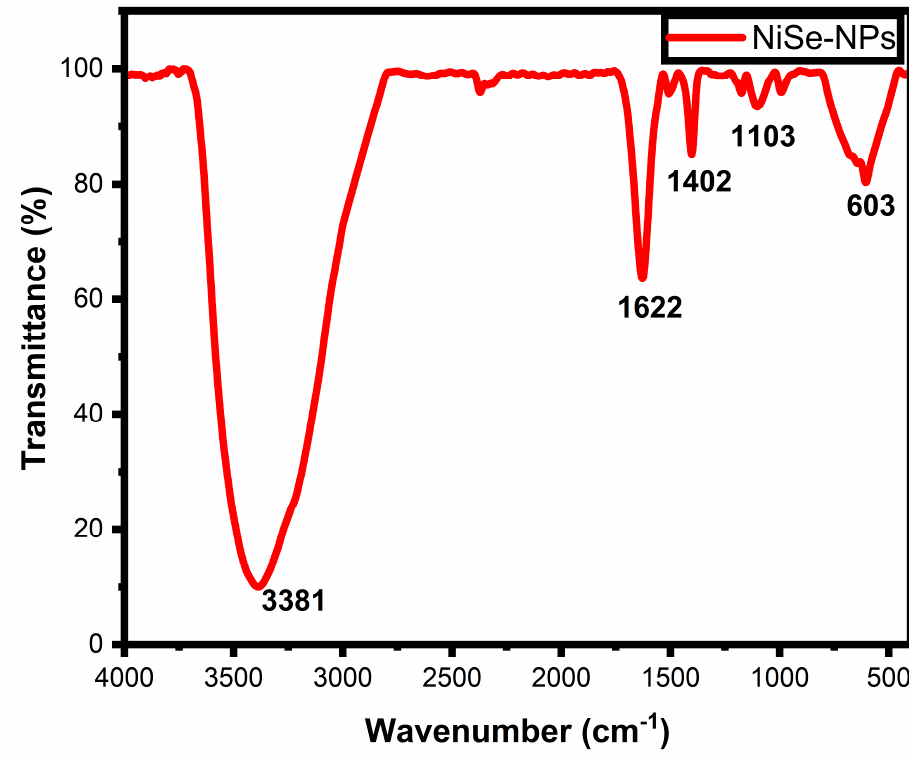
Figure 3. FTIR spectra of green synthesized NiSe